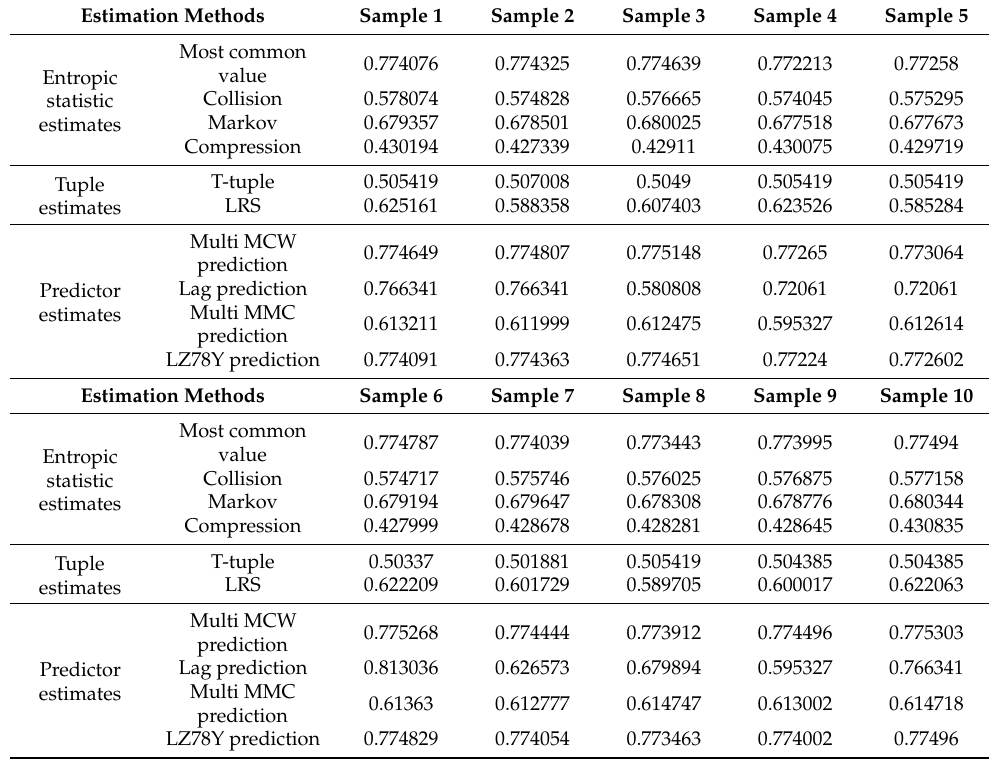
Table 5. Entropy rate of the conditioned true random